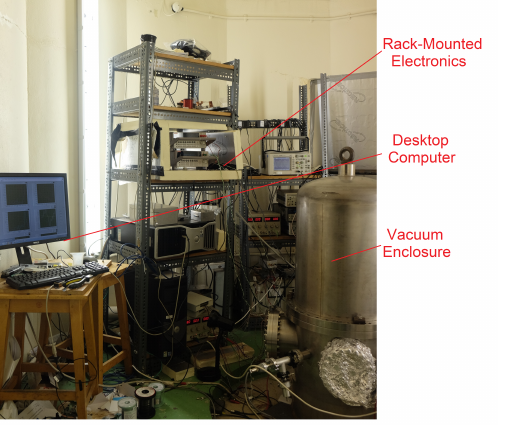
Figure 1. The initial microelectromechanical system (MEMS) sensor [23] was housed within a large vacuum tank and used large, rack-mounted electronics to measure the